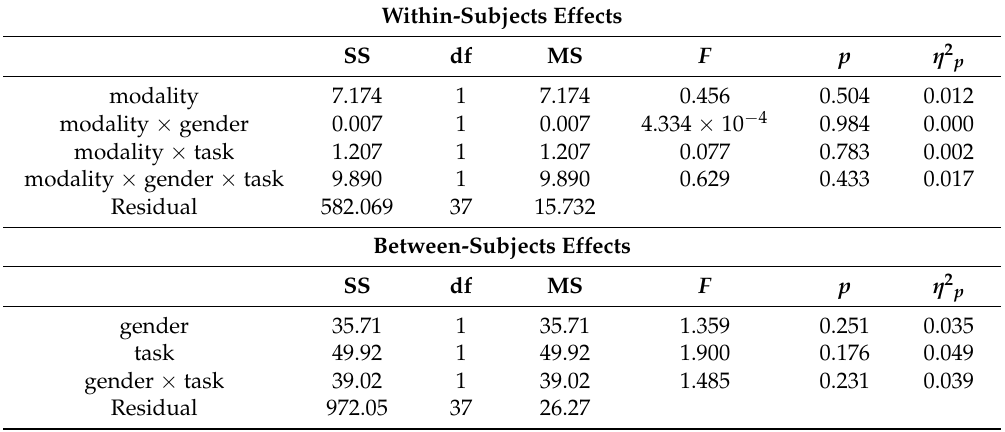
Table A18. Relative